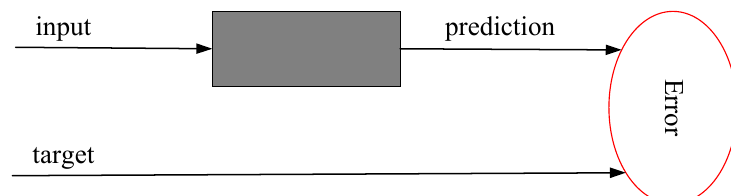
Figure 2. The diagram of the training process with labeled samples.